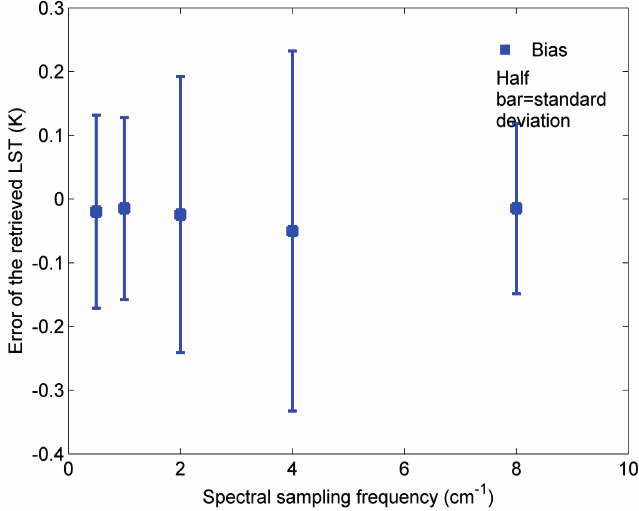
Figure 8. Errors of the ST retrieved using Equation (3) with refitted coefficients w i from each of the five simulation databases with 39 atmospheric profiles as a function of spectral sampling